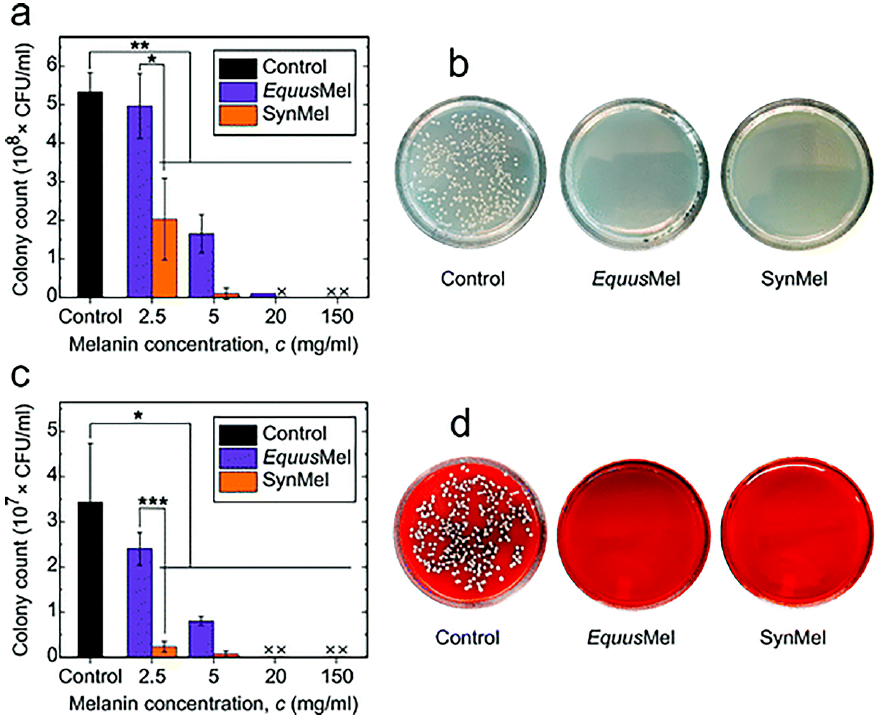
Figure 5. In vitro antibacterial activities are tested using ( a ) E. coli and ( c ) S. aureus . Statistically significant differences are indicated by *** p < 0.001, ** p < 0.01, and * p < 0.05 compared to the control. Representative images of agar plates are shown after incubating ( b ) E. coli and ( d ) S. aureus in melanin (150 mg mL − 1 ) for 4 h at 37 °C. Reprinted with permission from Ref. [175]. Copyright 2021 Royal Society of Chemistry.